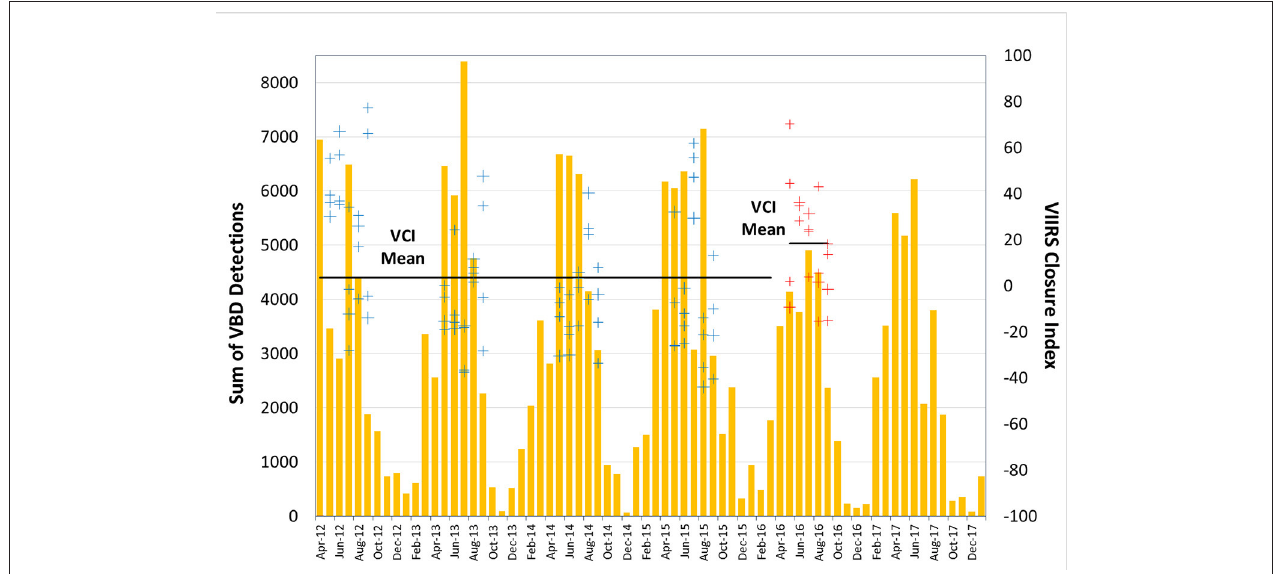
FIGURE 5 | The vertical bars indicate the monthly VIIRS boat detection tallies for the Vietnam closure area from April 2012 through January 2018. The points indicate the VCI values during the closure months and the same set of months in the pre-closure period. The VCI means for the closure and pre-closure periods are marked with black horizontal lines. The closure VCI are red and pre-closure blue.